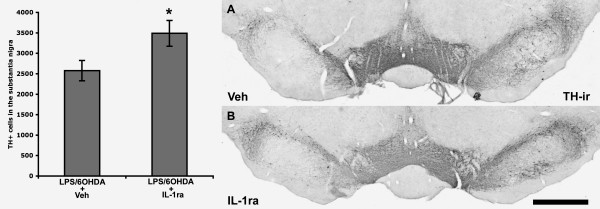
Interleukin-1 receptor antagonist (IL-1ra) reduces the amount of tyrosine hydroxylase-immunoreactive (TH-ir) cell loss associated with LPS and 6-OHDA (t-test, *p < 0.05). Each animal received LPS into the substantia nigra (SN), 9 days later started on either IL-1ra or vehicle (Veh) which continued through the experiment, and all animals then received an intra-striatal injection of 6-OHDA (5.0 μg) and were allowed 21 days until post-mortem analyses. Magnification, 2.5×; scale bar, 1.0 mm. Error bars, ± SEM; n = 8 per condition.